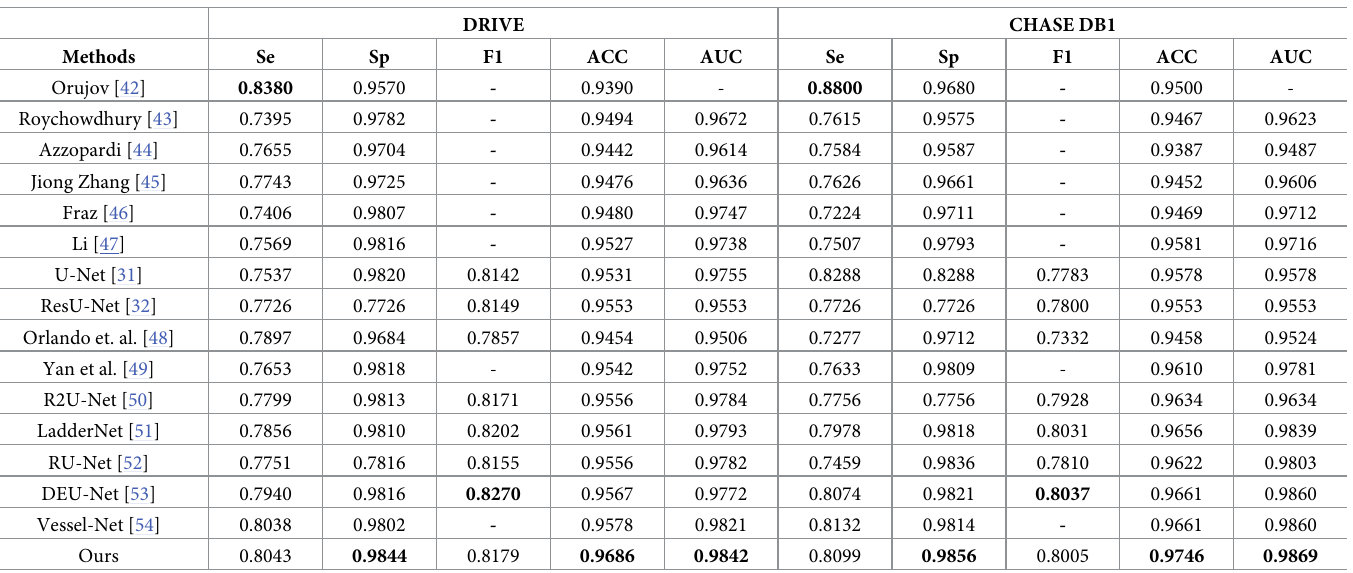
Fig 5. Comparison of ARU–Net and U–Net on CHASE DB1 dataset: (a) color fundus images; (b) ground truth; (c) segmentation result by ARU–Net; (d) segmentation result by U–Net. https://doi.org/10.1371/journal.pone.0273318.g005 Table 4. Results of different methods on DRIVE and CHASE